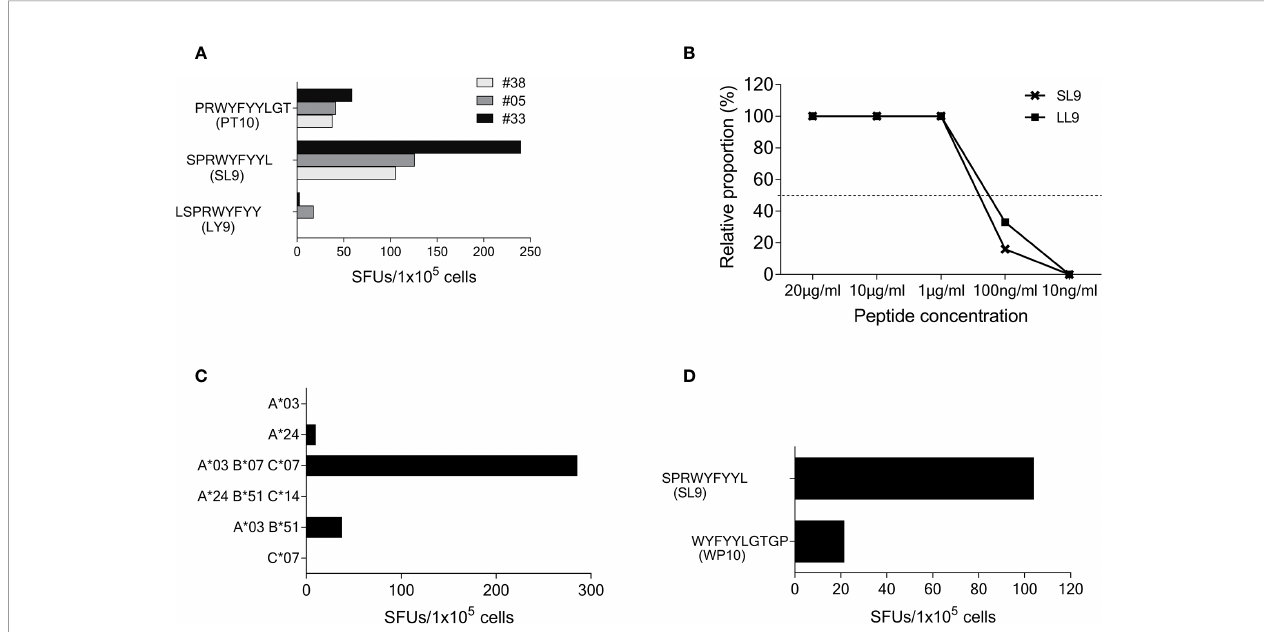
FIGURE 4 | SCoV-SL9 is an HLA-B*07 and B*35 restricted epitope. (A) Recognition of truncated peptides overlapping with SCoV-SL9 by donors #5, #33 and #38 in a g -IFN ELISpot assay. Shown are SFUs per 1x10 5 cells after subtraction of background reactions in wells with T-cell suspension without peptide. (B) Titration of the peptides SCoV-SL9 and OC43-LL9. 1x10 5 cells each from the T-cell line of #33 were incubated with either SCoV-SL9 or OC43-LL9 in a serial dilution with fi nal concentrations of 20µg/ml, 10µg/ml, 1µg/ml, 100ng/ml or 10ng/ml in a g -IFN ELISpot. SFUs are shown after subtraction of the background. Raw data are shown in Supplementary Table S2 . (C) 1x10 5 cells from the T-cell line of #5 were incubated in a g -IFN ELISpot assay with 1x10 5 B-LCLs loaded with the SCoV-SL9 peptide at a fi nal concentration of 20µg/ml. Shown are SFUs after subtraction of background, which was assessed by coincubating T-cell lines with B-LCLs without addition of peptide. Shown are the HLA alleles of the B-LCLs shared by the T-cell line (HLA-I type of subject #5: A*03, A*24, B*07, B*51, C*07, C*14). (D) 1x10 5 cells from the T-cell line of #41 were incubated in a g -IFN ELISpot assay with 1x10 5 cells of a B-LCL sharing only B*35 loaded with peptide SCoV-SL9 or the control peptide CoV-WP10 at a fi nal concentration of 20µg/ml. Data shown represent SFUs after subtraction of background. SCoV-SL9, SPRWYFYYL; OC43-LL9,